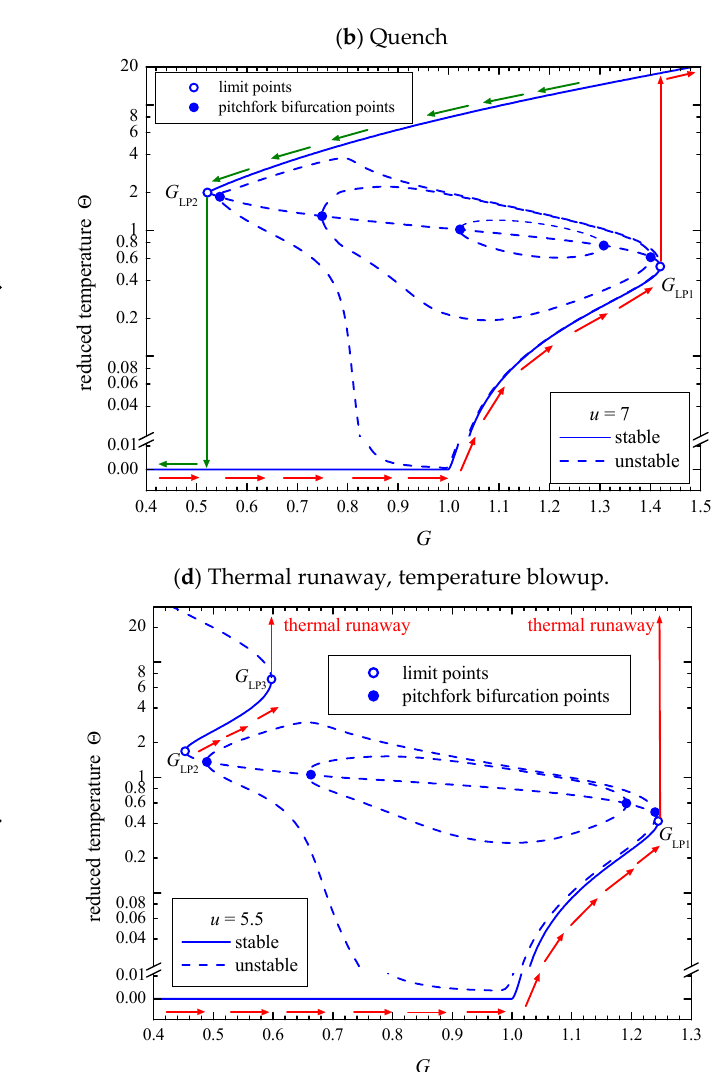
Figure 15. Superconducting composite. Quench, the destruction of bistability and thermal runaway.